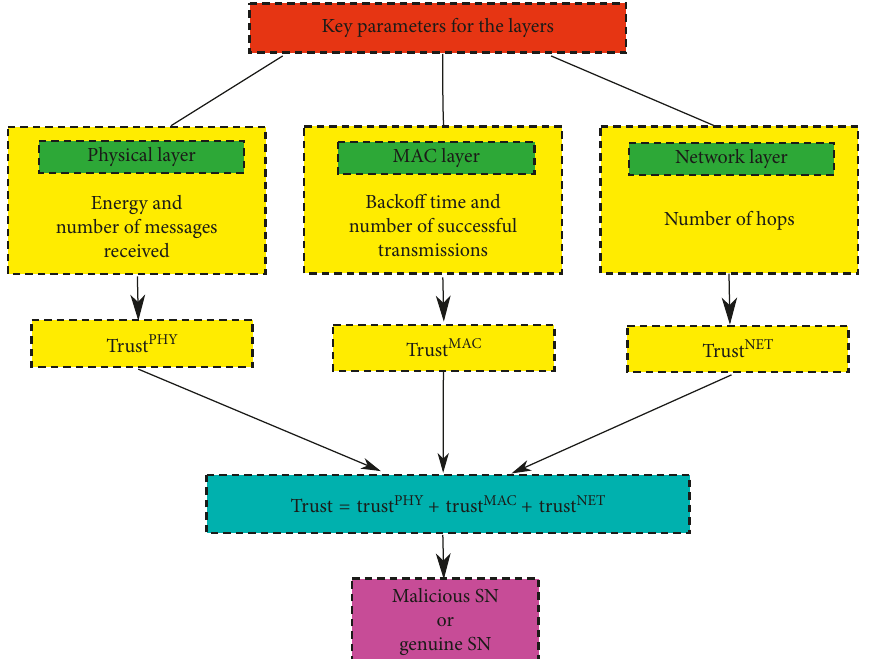
Figure 2: LB-IDS for clustered WSN.